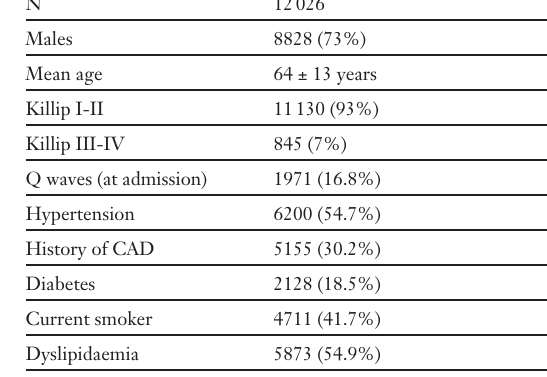
Baseline characteristics.